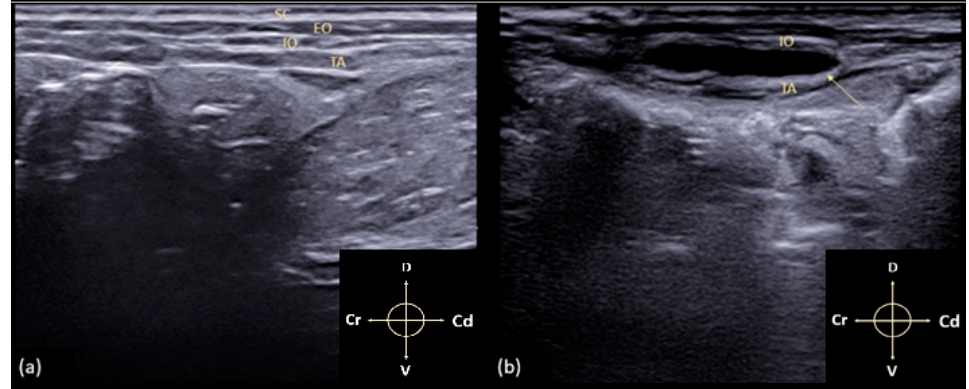
Figure 2. ( a ) Ultrasonographic image of the TAP anatomy in a rabbit. SC: subcutaneous tissue; EO: external abdominal oblique muscle; IO: internal abdominal oblique muscle; TA: transversus abdominis muscle; ( b ) the arrow points to a hypoechoic space between the IO and TA, corresponding to hydrodissection (i.e., separation of the muscular layers) within the TA fascia after the injection. Arrows indicate cranial (Cr), caudal (Cd), dorsal (D) and ventral (V) directions respectively.